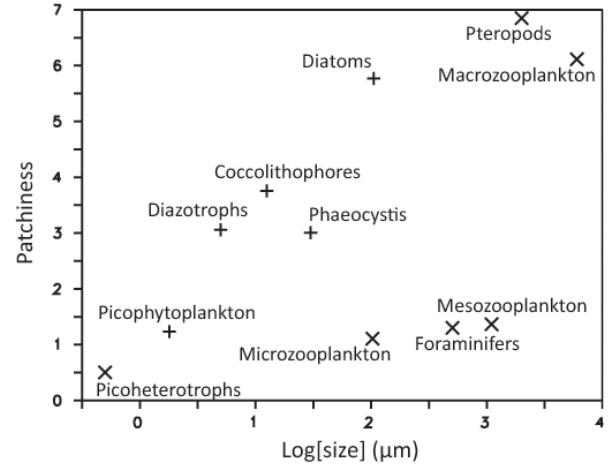
Figure 4. Patchiness (see Sect. 2.3) as a function of log (nominal organism size in µ m). Plusses: autotrophs; crosses: